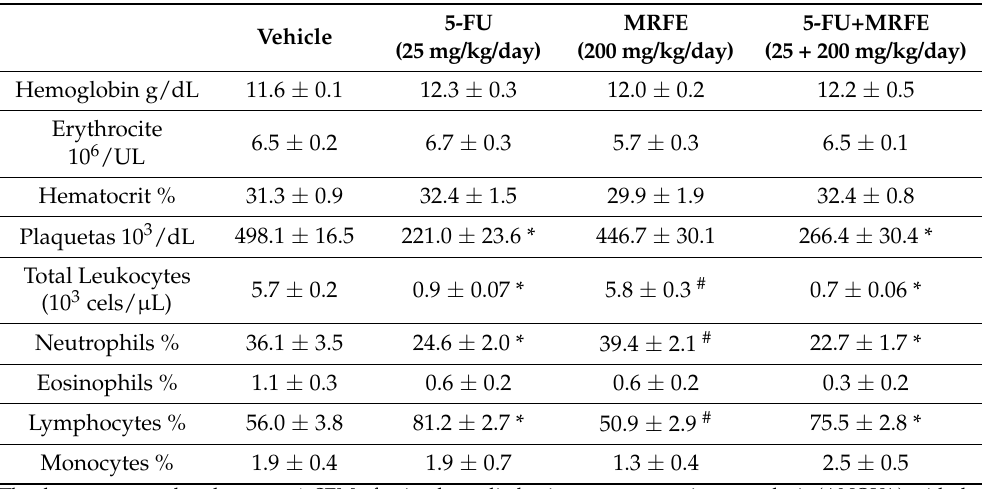
Table 4. Effect of 5-FU associated with MRFE on hematological parameters in animals transplanted with